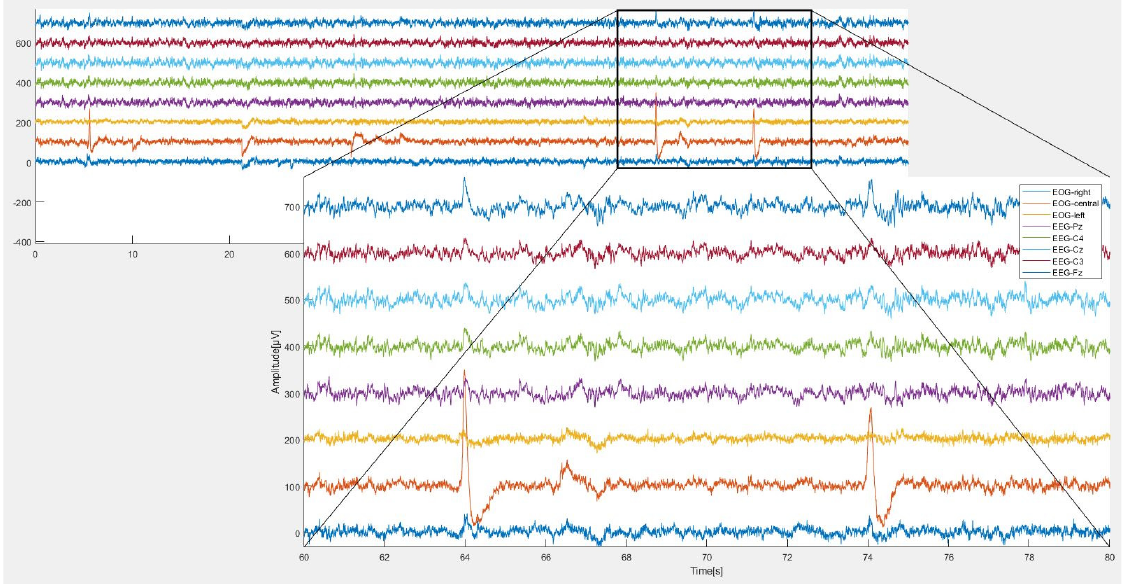
Figure 4. The original EEG with 22 channels of the MI-based BCI Competition IV dataset 2a.